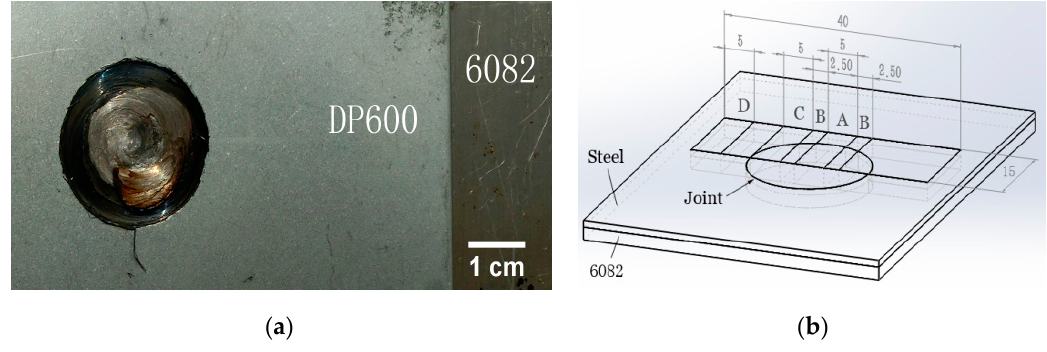
Figure 2. Keyhole-free FSSW joint of dissimilar 6082 aluminum alloy and DP600 galvanized steel: ( a ) the sample; ( b ) the sketch map of wire cutting.